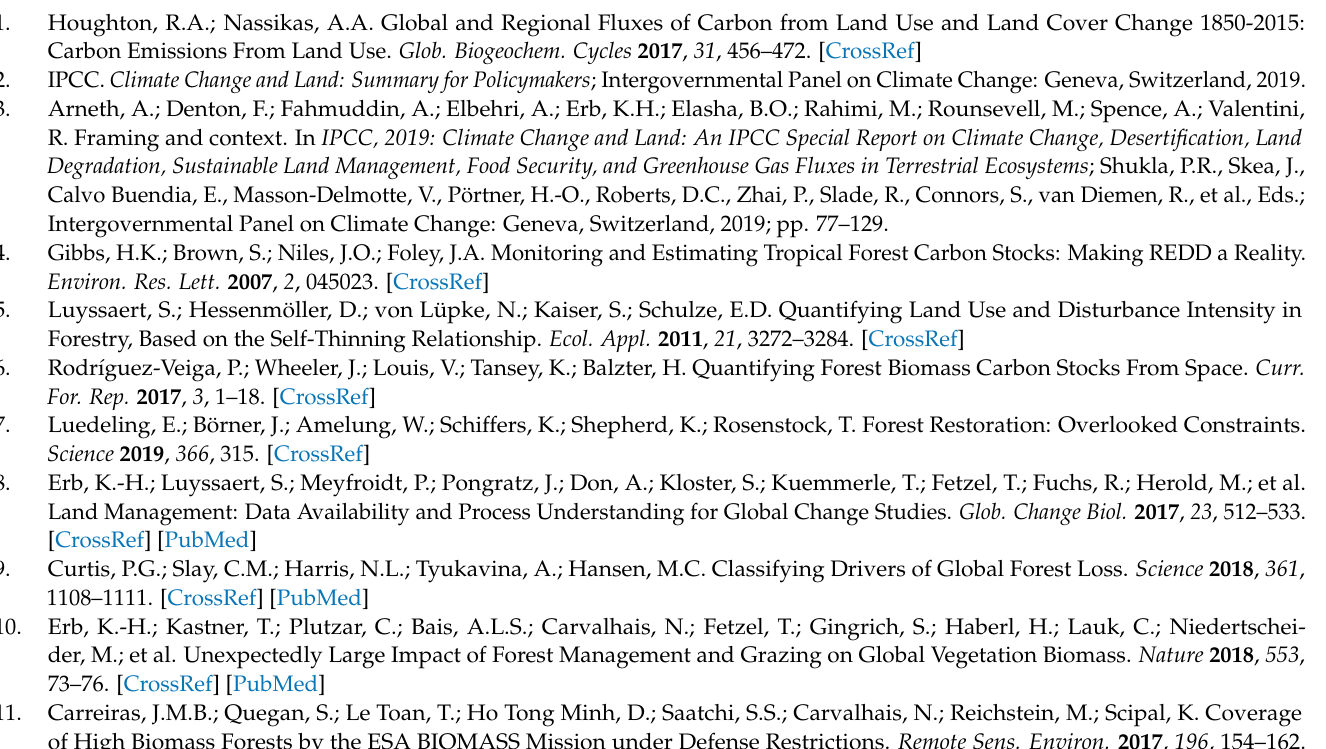
as the coefficient of variation. Figure S2: Tree cover (TC)—biomass carbon stocks (CS) correlations at the individual pixel level across tropical biomes for actual vegetation. Table S1: Actual tree cover and biomass carbon stocks datasets used in the study. Table S2: Potential tree cover and biomass carbon stocks datasets used in the